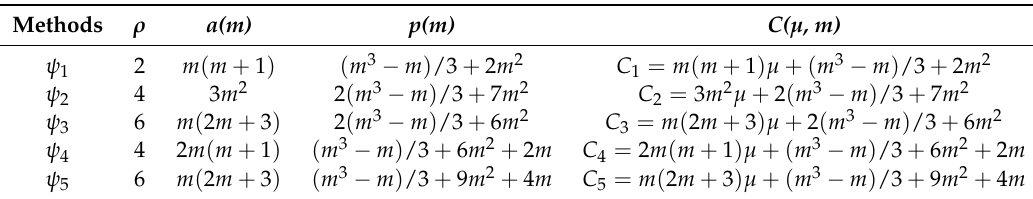
Table 1. Computational cost of the iterative